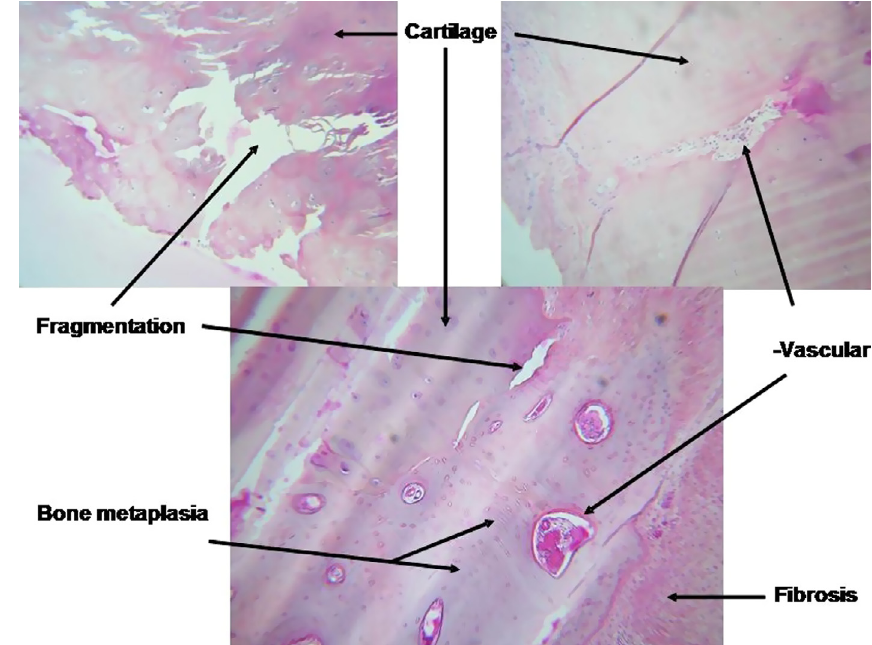
Figure 1. Histological analysis of explanted costal